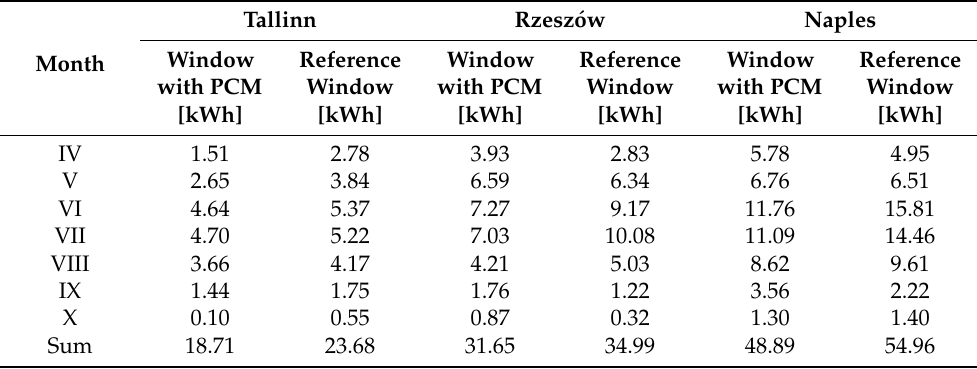
Table 2. Heat gains through windows with a PCM accumulator and reference windows operating in cool temperate (Tallinn), temperate (Rzesz ó w) and subtropical (Naples)